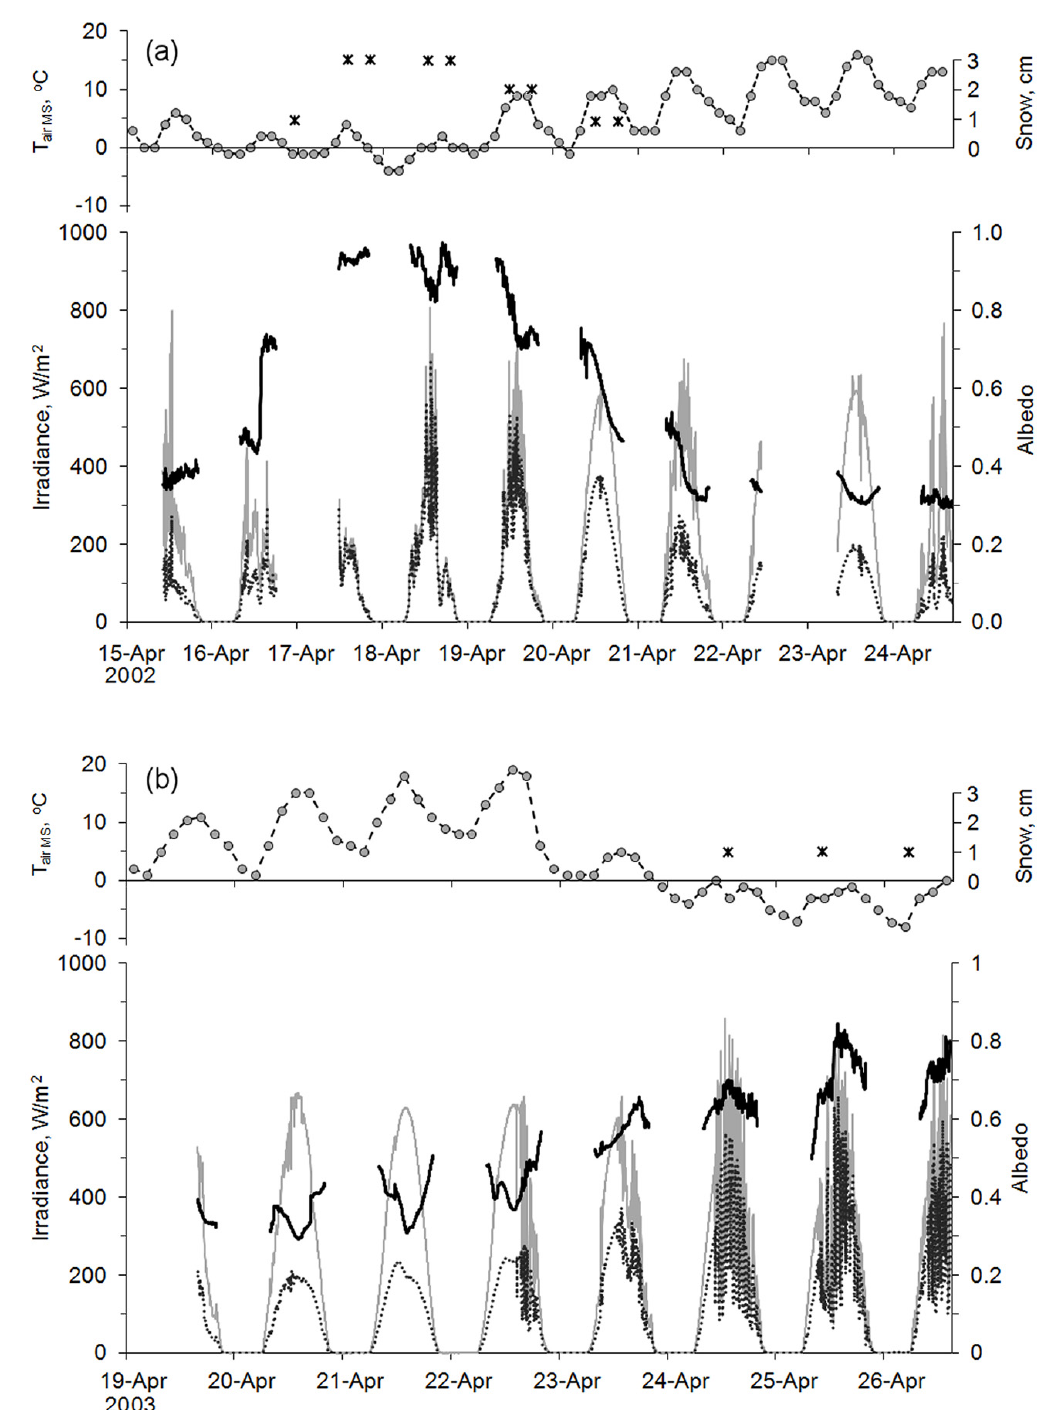
Figure 4. Temporal variability of air temperature (circles, dashed line, MS Petrozavodsk data, temporal resolution 3 h), downwelling (grey line) and upwelling (dotted black line) planar irradiance on the surface of Lake Vendyurskoe, and lake surface albedo (solid black line, temporal resolution 2 min) during April 15–24, 2002 ( a ) and April 19–26, 2003 ( b ). Asterisks denote snow thickness, cm.